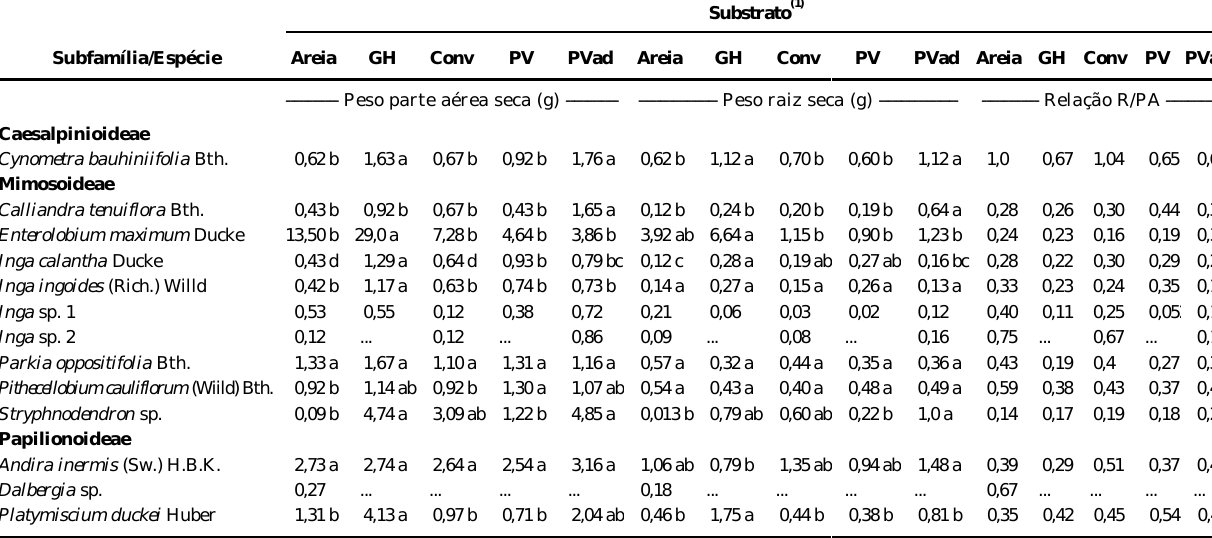
(ARA) em todos os substratos, e a maior parte das estirpes isoladas eram de Bradyrhizobium sp. Características morfológicas e bioquímicas dessas estirpes podem ser encontradas em Moreira (1991) e Moreira et al.